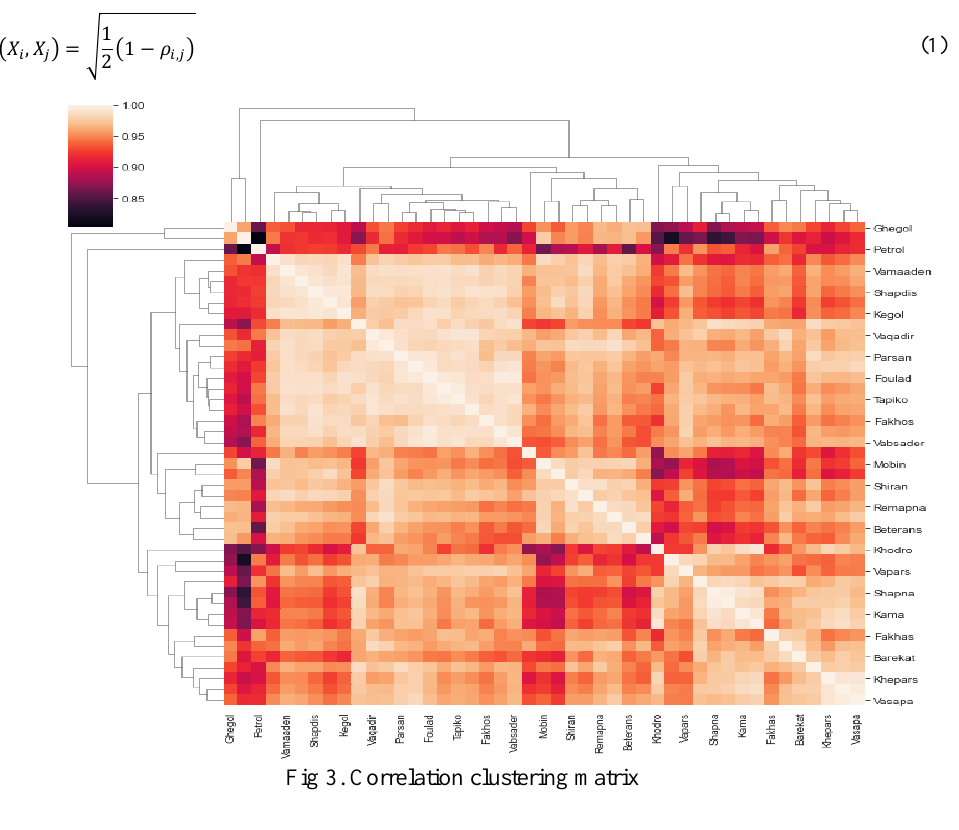
Fig 3. Correlation clustering